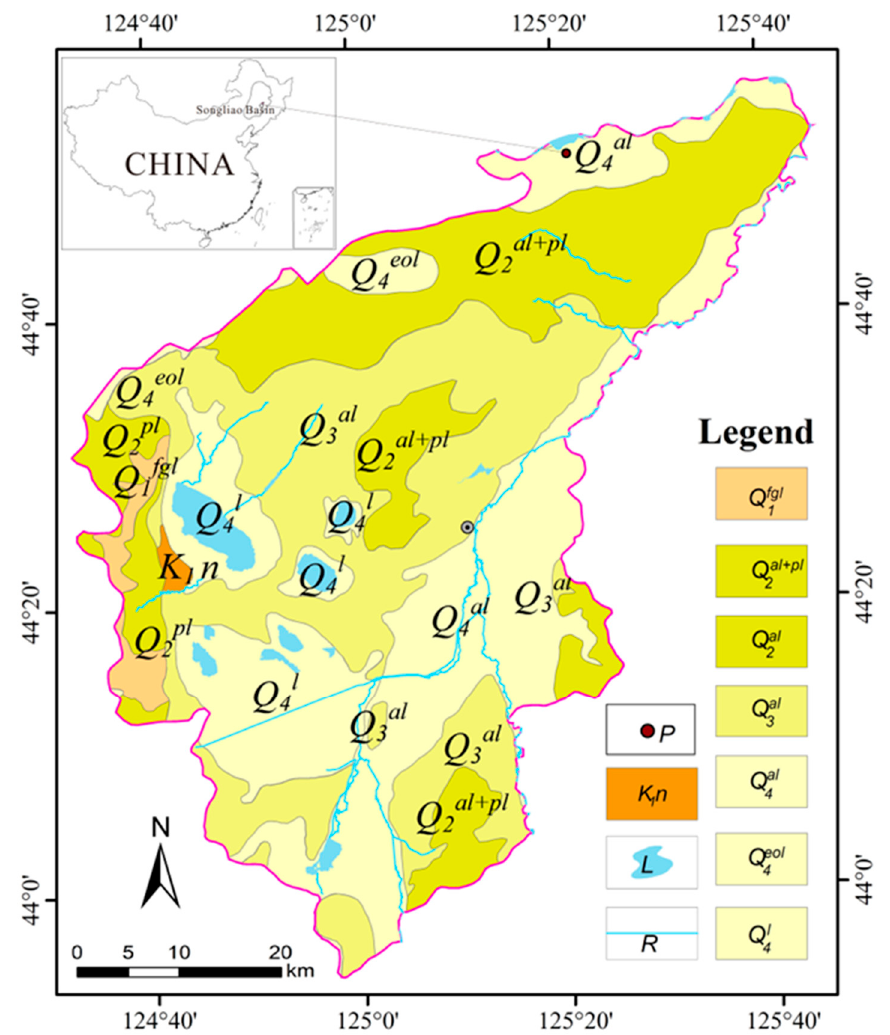
Figure 2. Geological map of Nong’an City [19]. (Q 1fgl represents the glaciofluvial accumulation layer of the Gelasian Quaternary Pleistocene; Q 2al+pl represents the alluvium and diluvium of the Middle Quaternary Pleistocene; Q 2al represents the alluvium of the Middle Quaternary Pleistocene; Q 3al represents the alluvium of the Upper Quaternary Pleistocene; Q 4al represents the alluvium of the Quaternary Holocene; Q 4eol represents the eolian deposit of the Quaternary Holocene; Q 4l represents the lake sediments of the Quaternary Holocene; K 1n represents the mudstone or clastic rock of the Lower Cretaceous; L represents the lakes; R represents the rivers; P represents the sampling site of the oil shale in the area.)